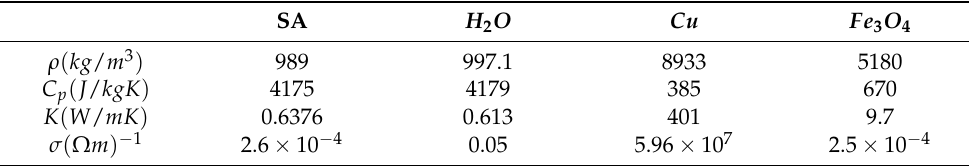
Table 1. Thermophysical properties of SA , H 2 O , Cu , Fe 3 O 4